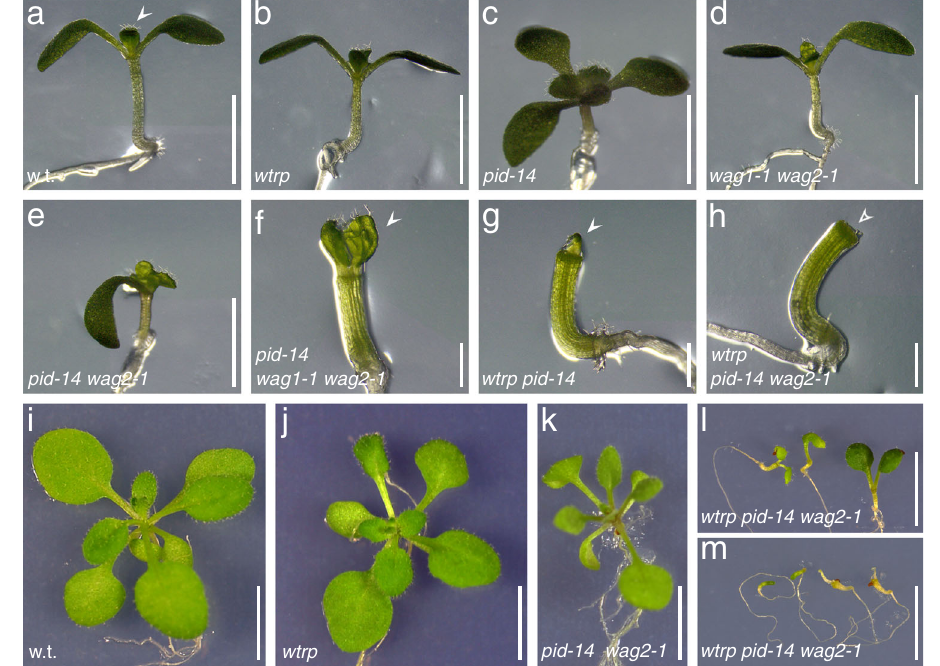
Fig. 4 | Genetic interaction between PID/WAG and WAV3/WAVH genes in the regulation of PIN2 polarity. Wild type (w.t.; a ), wav triple ( wtrp ; b ), pid-14 ( c ), wag1-1 wag2-1 ( d ), pid-14 wag2-1 ( e ), pid-14 wag1-1 wag2-1 ( f ), wav triple pid-14 ( g ), wav triple pid-14 wag2-1 ( h ) hypocotyl and cotyledon phenotypes of seedlings, 5